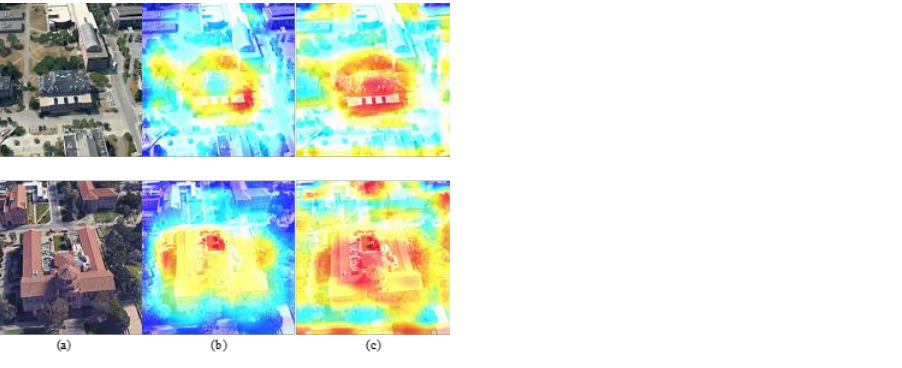
Figure 4. Grad-CAM [51] visualization of heatmaps: ( a ) Original images; ( b ) LPN methods; ( c ) MSBA methods.